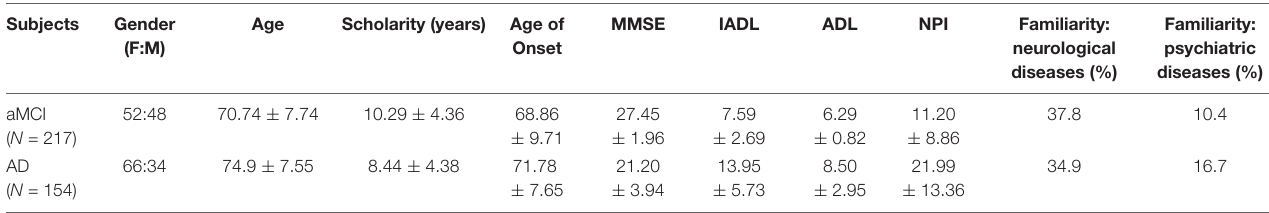
Detailed information about the patients recruited for the study are summarized. Mean ± Standard Deviation (SD) are shown for all the features except for familiarity, which has been reported as percentage in the cohort. The overall cognitive functions were measured by Mini-Mental State Examination (MMSE). Patient’s functional abilities in daily living were measured by Activities of Daily Living (ADL) and Instrumental Activities of Daily Living (IADL). Psychopathology-related and behavioral symptoms were measured by means of Neuropsychiatric Inventory (NPI) scale. aMCI, amnestic Mild Cognitive Impairment; AD, Alzheimer’s disease.